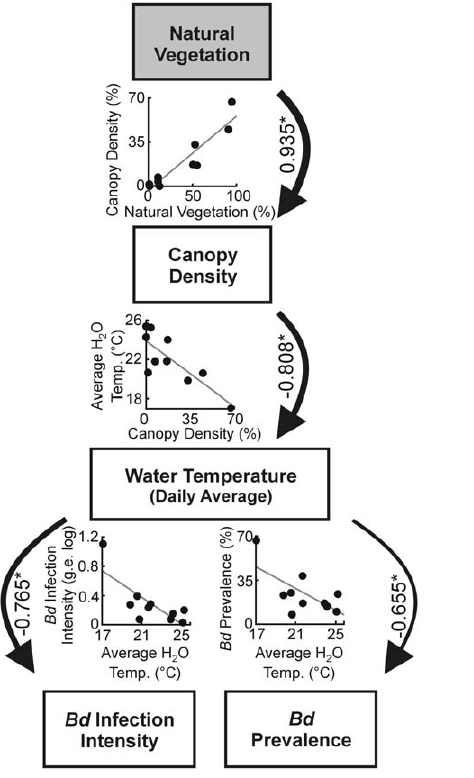
Figure 2. Path analyses indicating a unidirectional causal relationship between natural vegetation, canopy density, water temperature, and Bd . The relative strength of each effect is indicated by line width. Linear regressions are shown for each relationship. Numbers are standardized path coefficients (*P , 0.05). Diagram shows models for Bd prevalence and infection intensity combined.